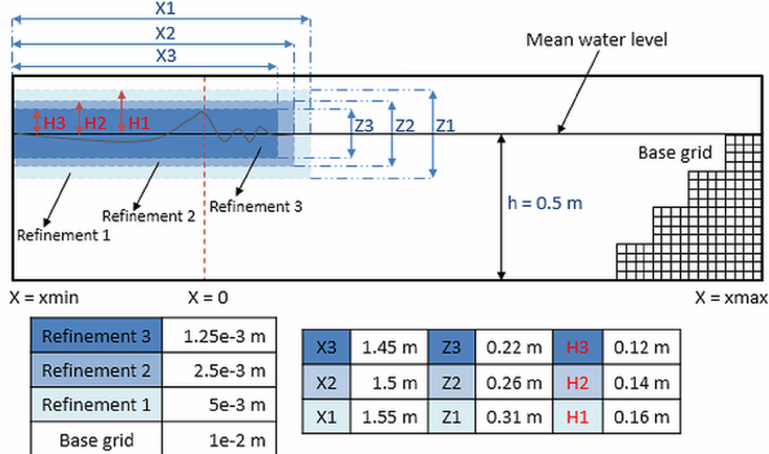
Figure 15. The computational domain with three local grid refinement regions around the area of interest. The location x = 0 m was considered as the target location where the focusing events from the measurements were reproduced in the computational domain. Note that the base grid covers the entire